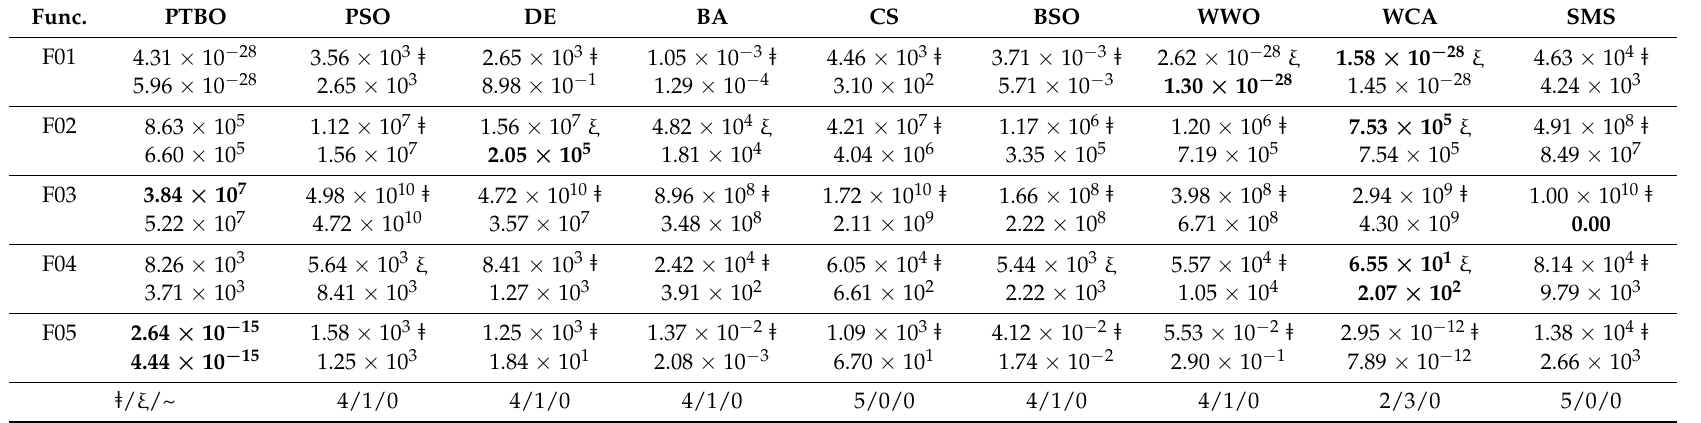
Table 8. The results of solution accuracy for the uni-modal